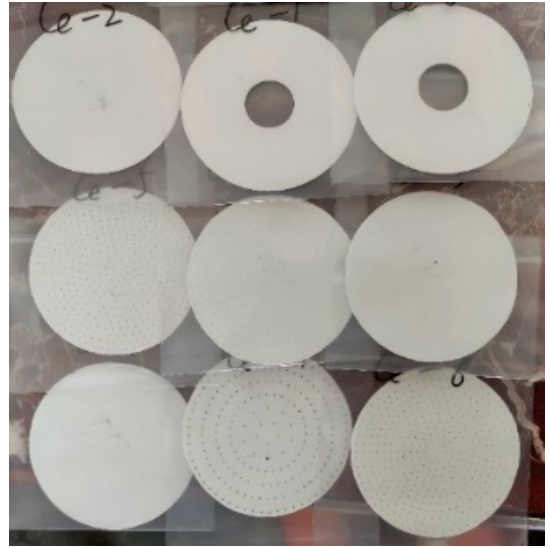
Figure 3. The filter paper after cerium-aerosol